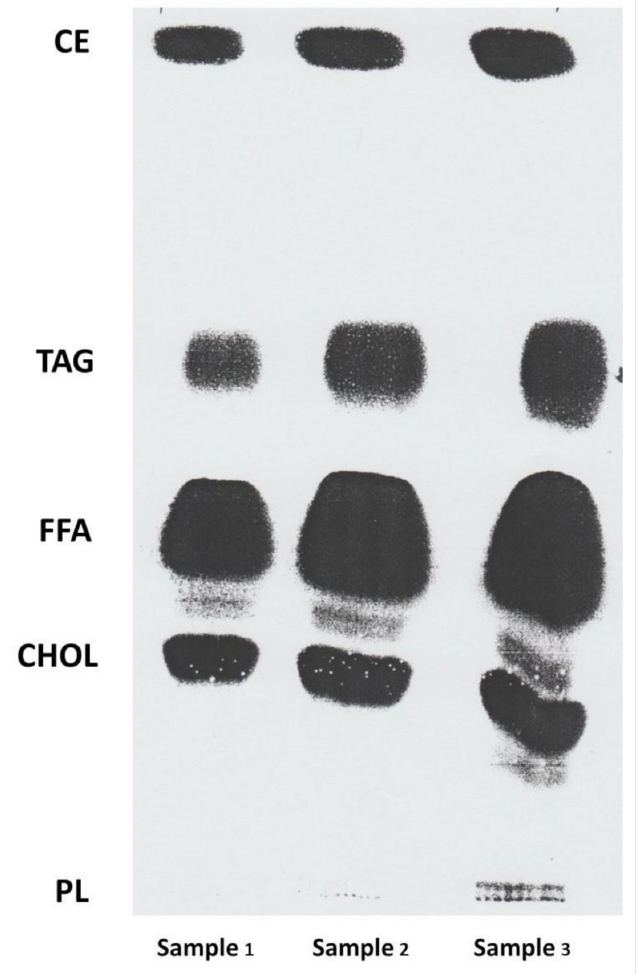
Figure 1. Lipid fractions of lyprinol (green-lipped mussel) separated by using a thin layer chromatog- raphy (TLC) technology. Lipid fractions were separated by thin layer chromatography (TLC) on silica gel plates (Silica gel 60H, Merck, Darmstadt, Germany). The solvent system for all TLC was petroleum spirit/diethyl ether/glacial acetic acid (85:15:2 by volume). Lyprinol (50 g) was made up in 1 mL of chloroform, and from this stock, 10 µ L (sample 1), 20 µ L (sample 2) and 30 µ L (sample 3) were spotted as shown above. Lipid classes were visualised with fluorescein 5-isothiocyanate against TLC standard 18-5 (Nuchek Prep Inc, Elysian, MN). Lipid fractions identified from left top to bottom are cholesterol esters (CE), triacylglycerols (TAG), free fatty acids (FFA), cholesterols (CHOL) and phospholipids